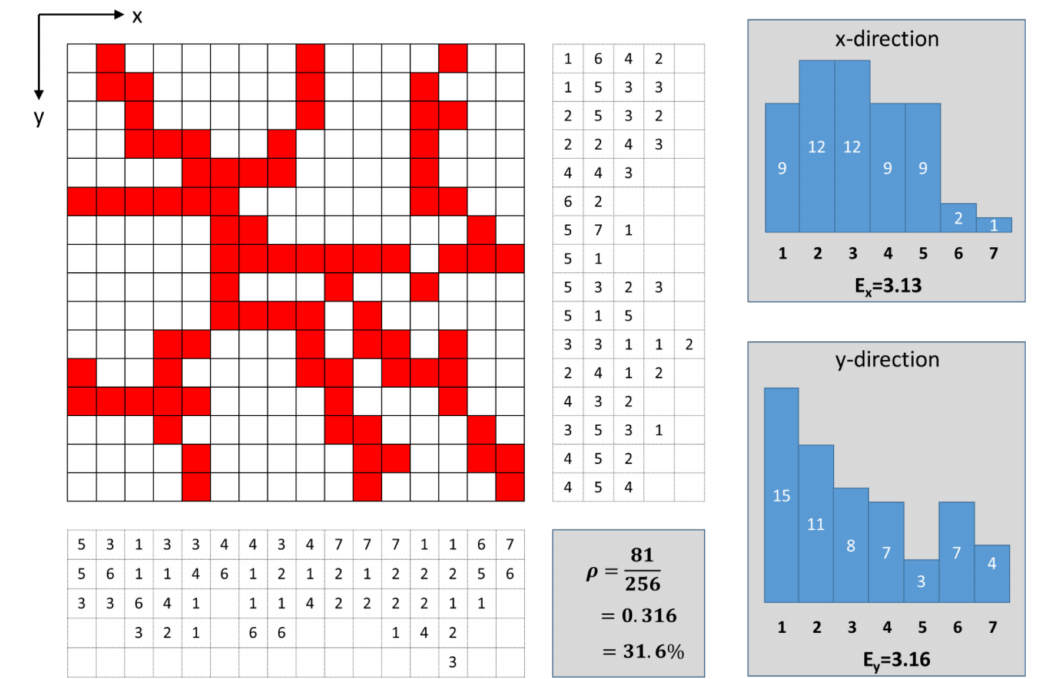
Figure 2. Example to explain the chord length